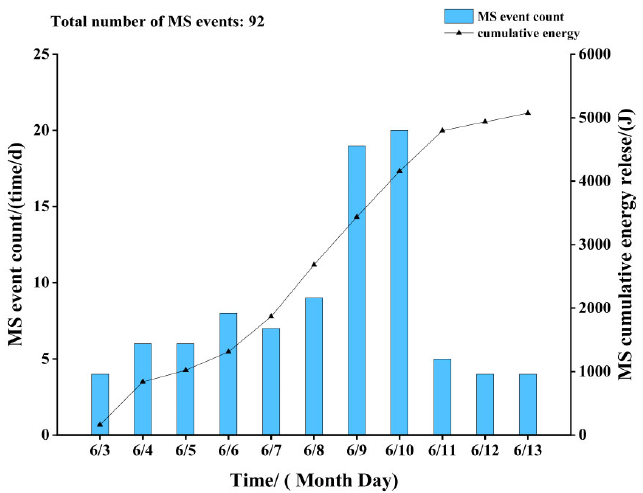
Figure 9. Temporal distribution of microseismic events.